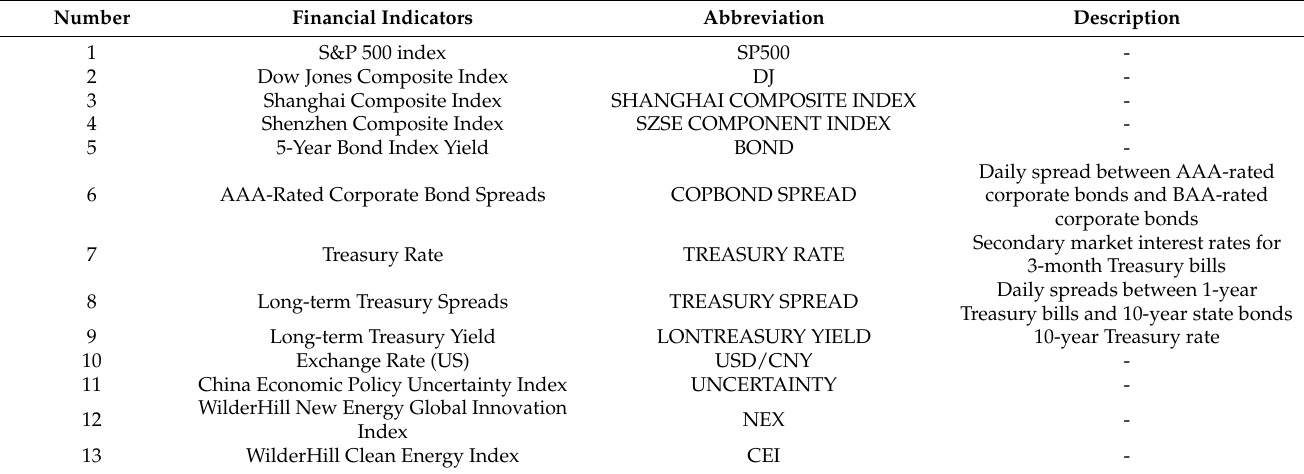
Table 2. Description of financial indicators.